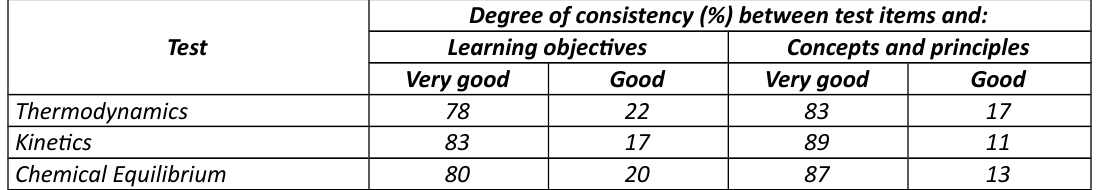
Table 3. Summary of second judges’ evaluaton of the built tests